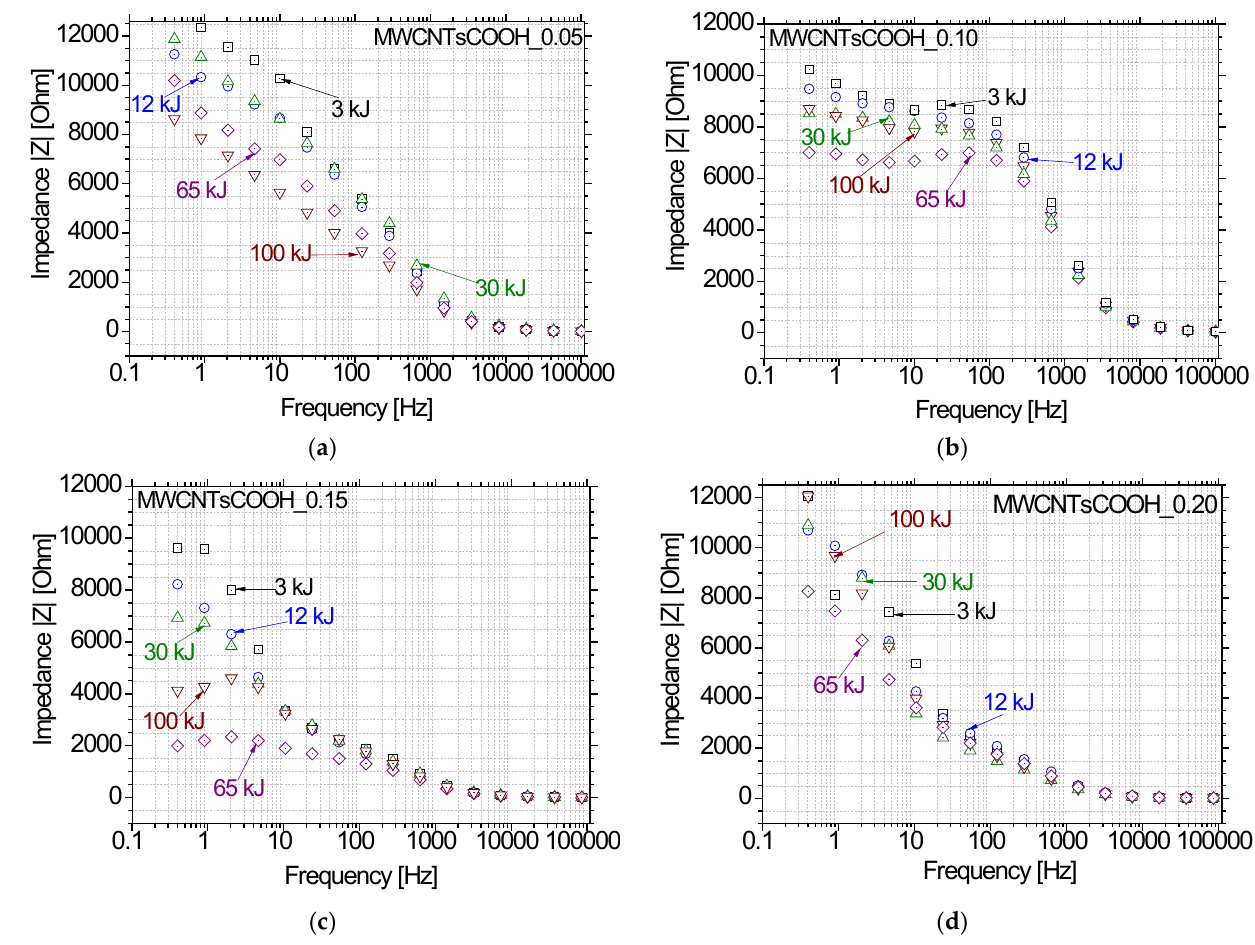
Figure 6. Bode plots of MWCNTsCOOH aqueous dispersions at different ultrasonic energy levels and concentrations of ( a ) 0.05, ( b ) 0.10, ( c ) 0.15 and ( d ) 0.20 wt.%, respectively.